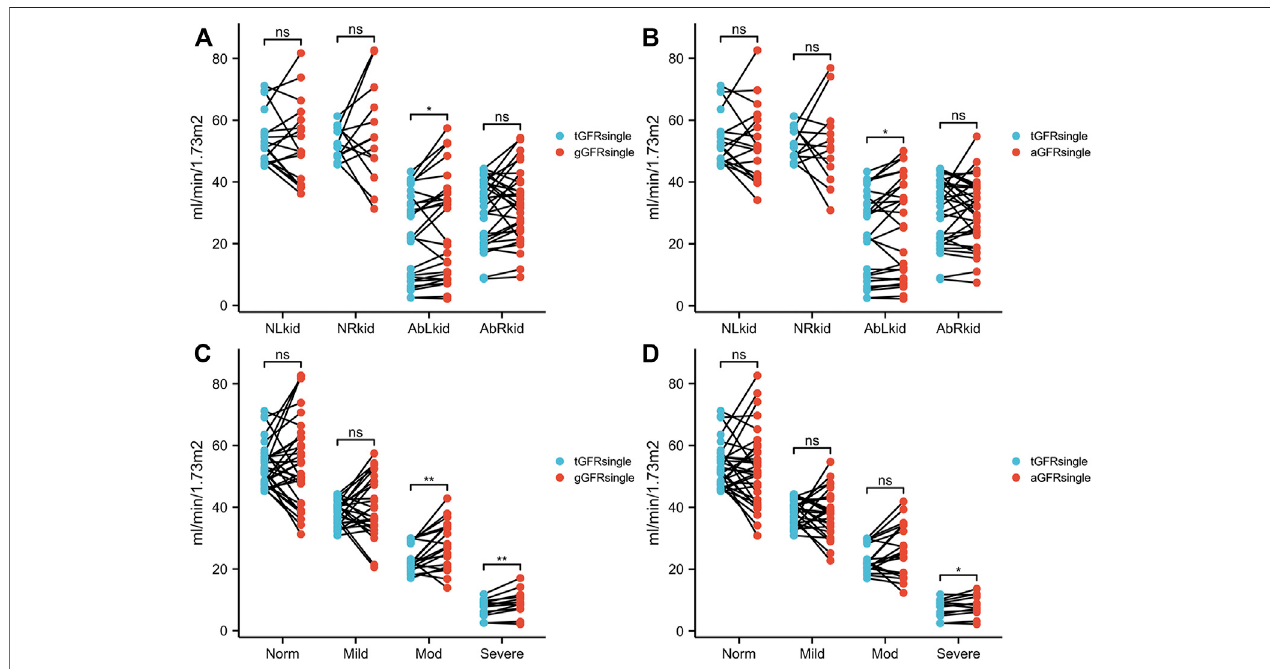
FIGURE2| Comparison betweengGFR single andtGFR single (A,C) andbetweenaGFR single andtGFR single (B,D) inpatients withhydronephrosis.NLkid,normal left kidney; NRkid, normal right kidney; AbLkid, abnormal left kidney; AbRkid, abnormal right kidney; Norm, normal; Mod, moderate; GFR, glomerular fi ltration rate; gGFR single , single GFR measured using the Gates method; aGFR single , single GFR measured by the renal region of interest area correction by CT method; tGFR single , single GFR, total GFR measured by the two-sample method multiplied by the differential renal function. p < 0.05 was considered statistically signi fi cant. ns, p ≥ 0.05, * p < 0.05, ** p < 0.01.